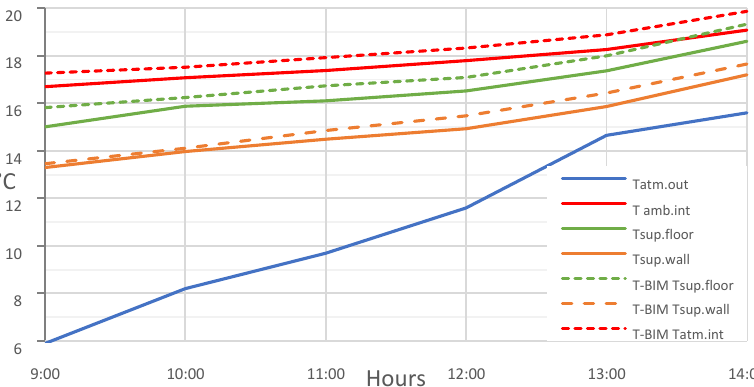
Figure 9. Average simulation and monitored surface temperatures of the wall and the floor, of Room W1, 19 November 2021.